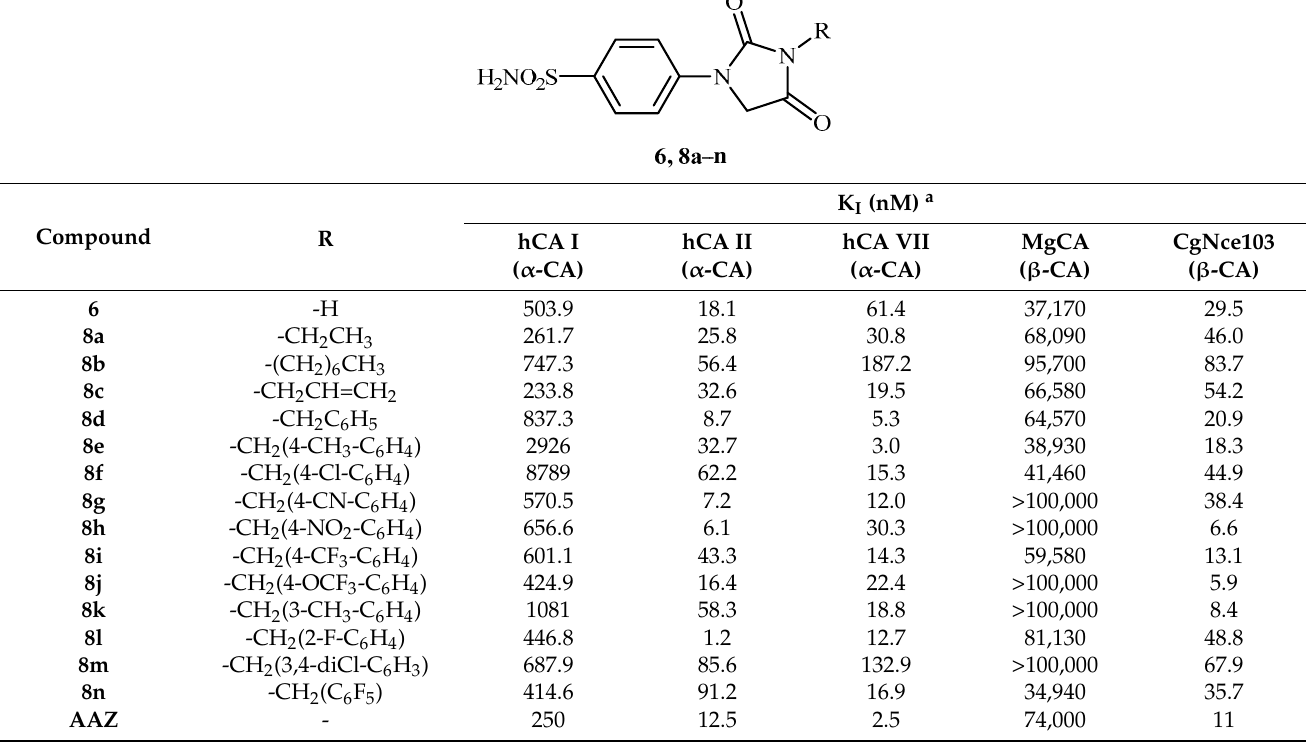
Table 1. Inhibition data of human CA isoforms hCA I, II, and VII and fungal β -CA isoforms MgCA, from M. globosa , and CgNce103, from C. glabrata , with compounds 6 and 8a – n in comparison with AAZ as standard drug by a stopped flow CO 2 hydrase assay [67].